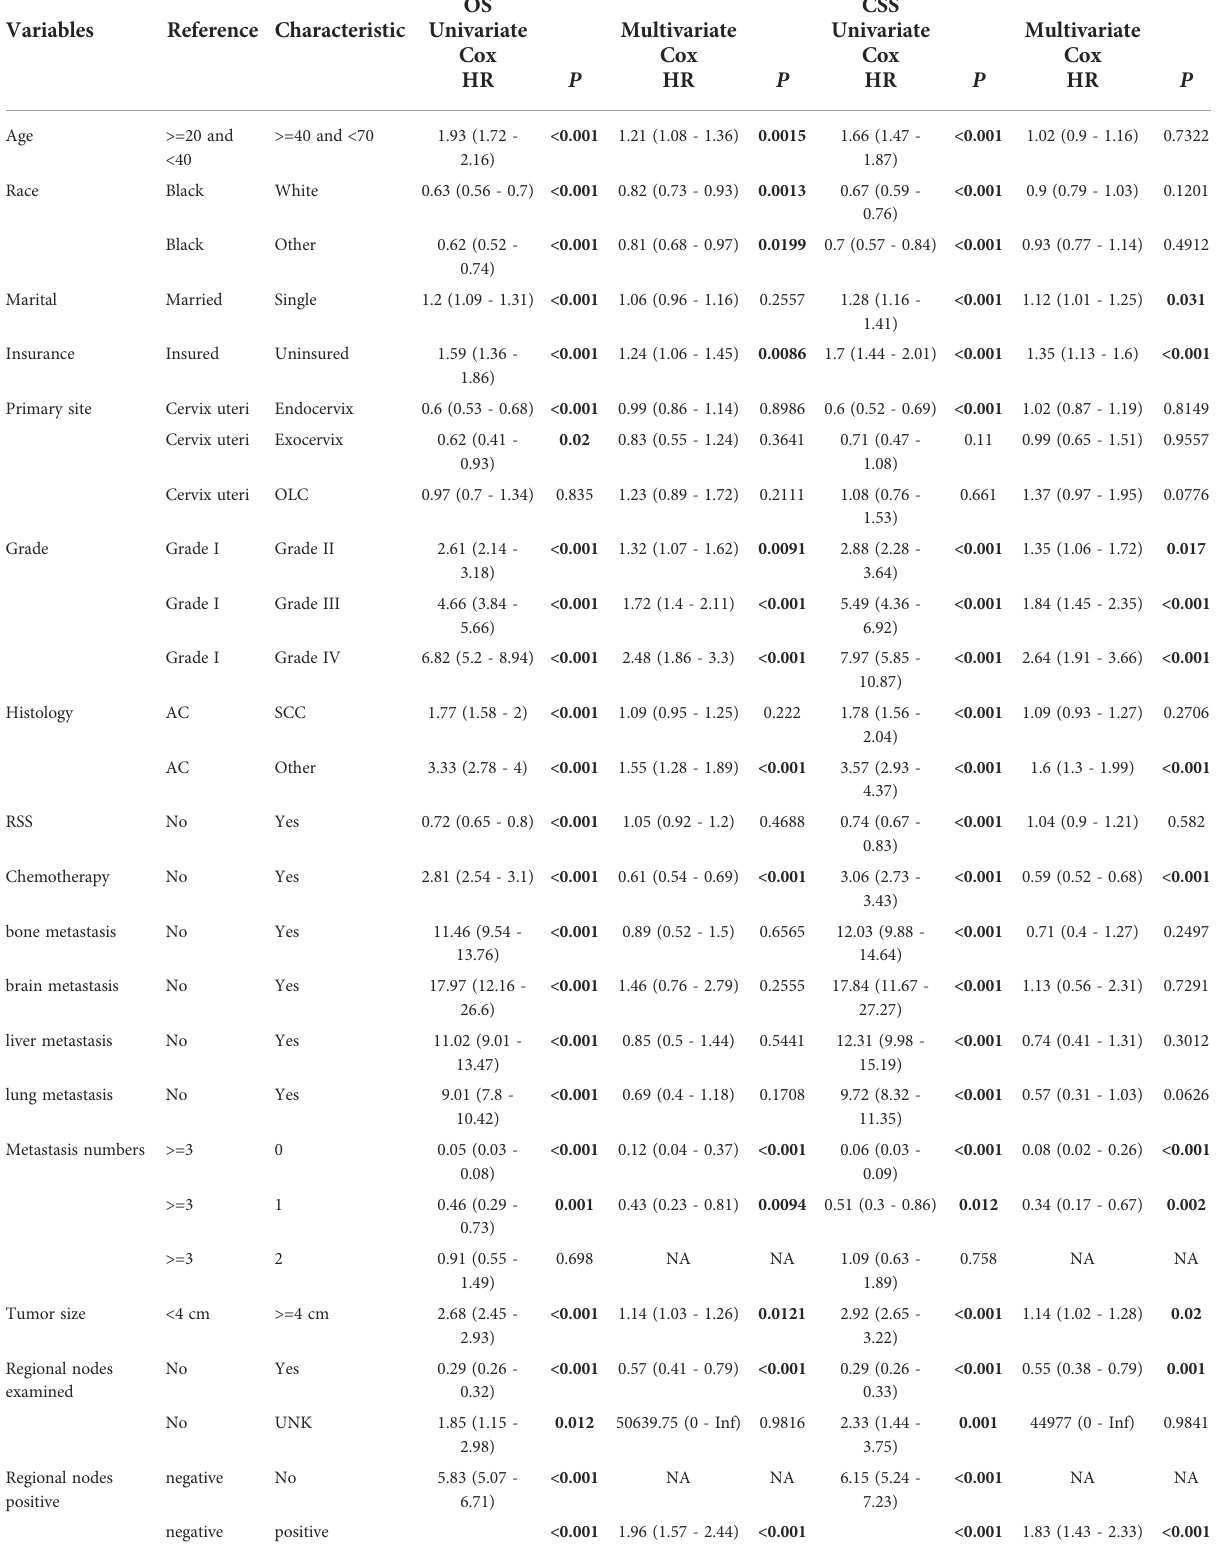
TABLE 2 Univariate and multivariate Cox regression analysis of OS and CSS in cervical cancer (training